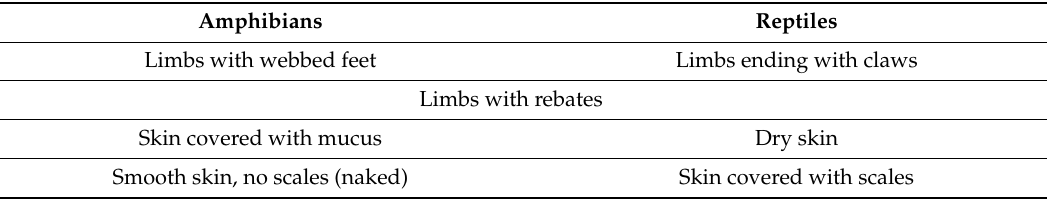
Table A3. List of